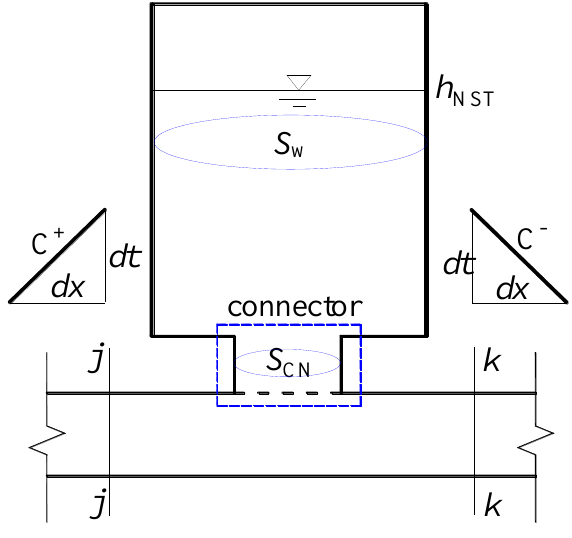
Figure 5. Boundary model of the surge tank.